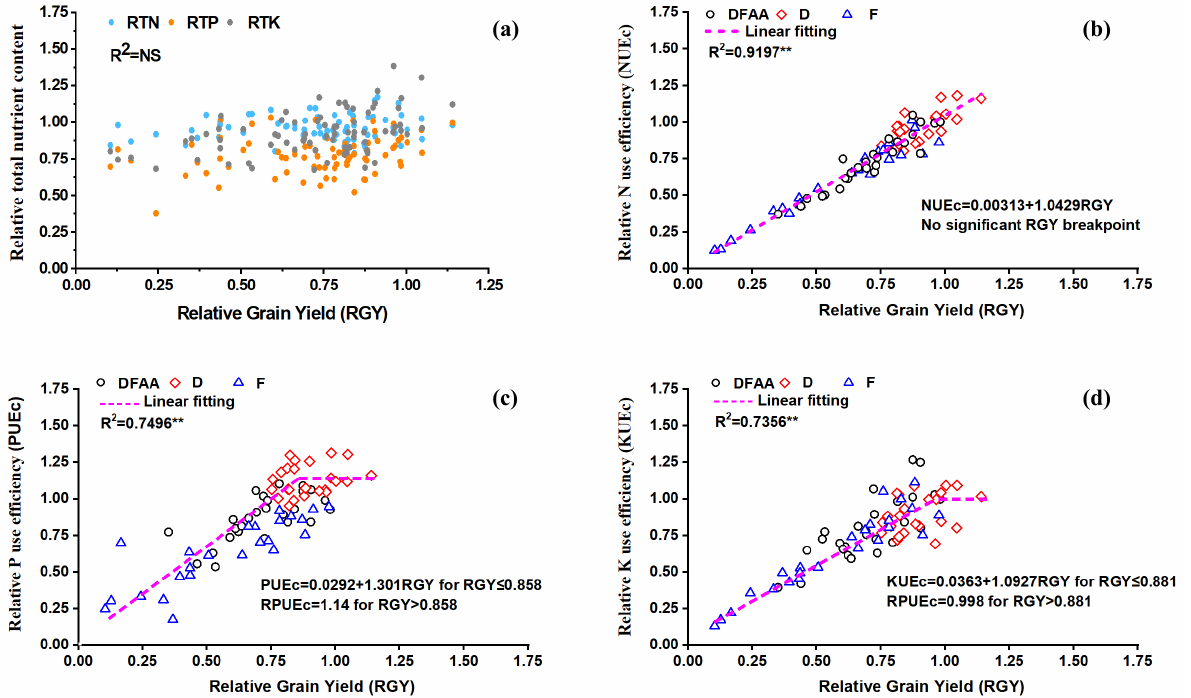
Figure 6. Relationships of ( a ) relative total nutrient content (RTN, RTP and RTK) and relative grain yield (RGY), and ( b – d ) relative nutrient use efficiencies (NUEc, PUEc and KUEc) and RGY at maturity in 2016–2018. RTN, relative total N content; RTP, relative total P content; RTK, relative total K content. “NS” means not significant; ** indicates significant differences at 0.01 probability levels. DFAA, drought followed by flooding; D, drought followed by no flooding (drought alone); F, no drought followed by flooding (flooding alone). Table 4. Correlation analysis of the main morpho-agronomic traits at the end of water stresses with grain yield, total uptake of N, P and K, specific absorption rates (SAR-N, SAR-P and SAR-K), nutrient use efficiencies (NUE, PUE and KUE) at maturity in 2016–2018.